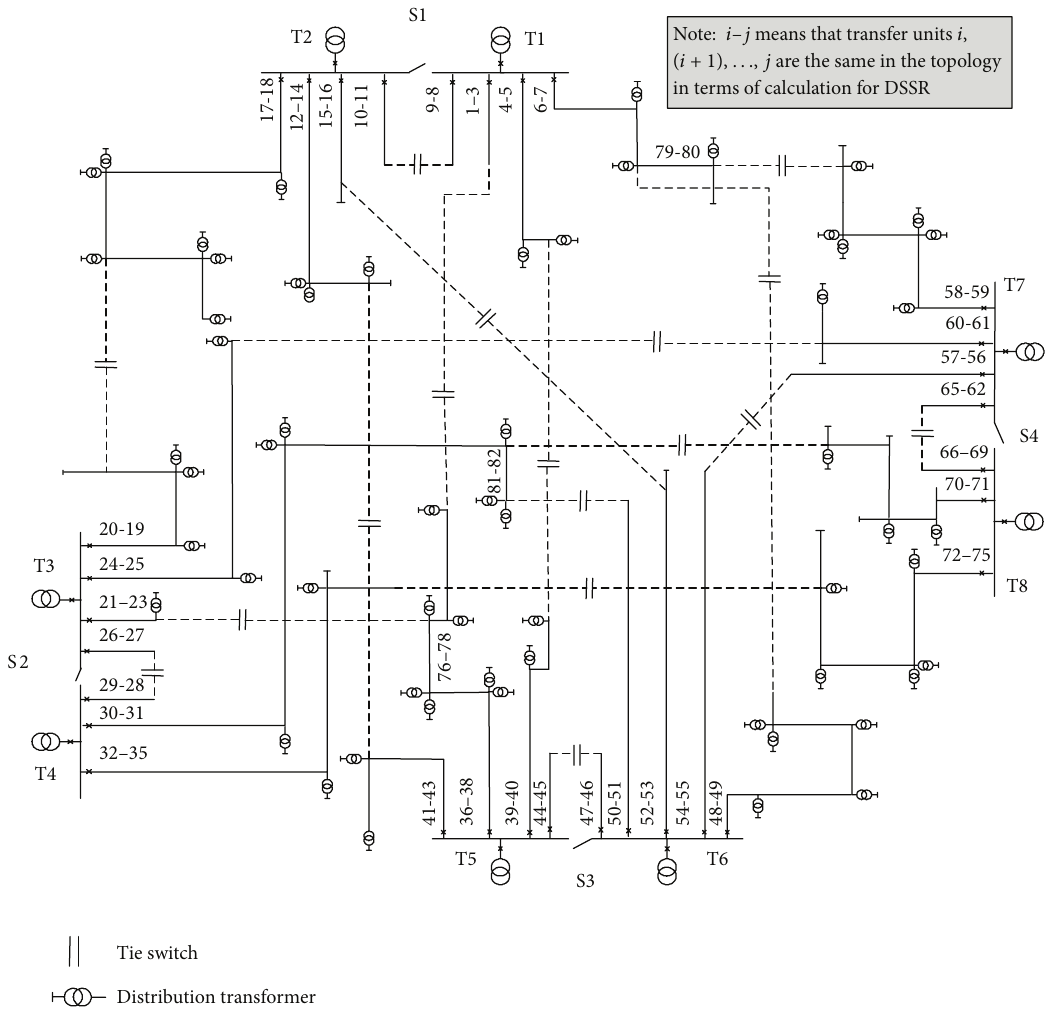
Figure 4: Test case with eight substation transformers.